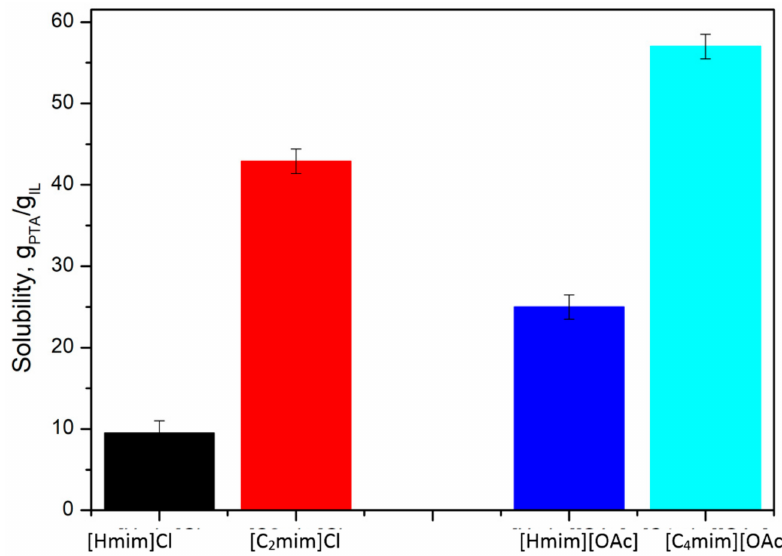
Figure 5. The comparison of the solubility of PTA in protic and aprotic ionic